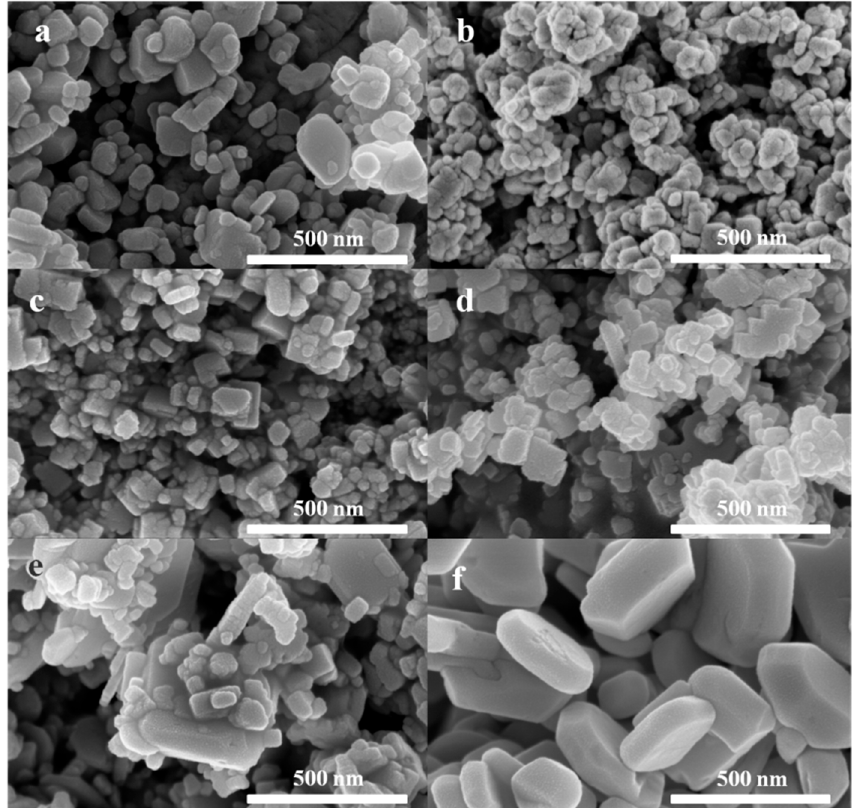
Figure 5. SEM images of ( a ) BaF 2 , ( b ) BaCl 0.025 F 0.975 , ( c ) BaCl 0.05 F 0.95 , ( d ) BaCl 0.1 F 0.9 , ( e ) BaCl 0.25 F 0.75 and ( f ) BaClF.